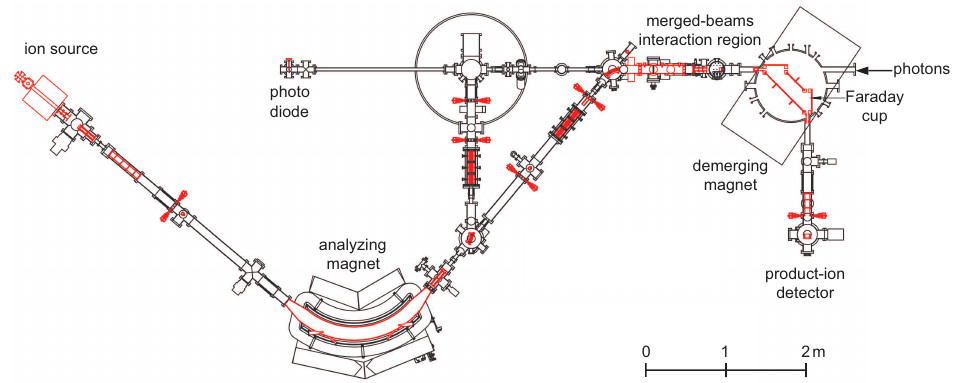
Figure 1. Sketch of the photon-ion merged-beams setup PIPE (Photon-Ion spectrometer at PETRA III). Ion-optical elements, such as focusing lenses, beam deflectors, collimating slits and Faraday cup are drawn in red color. This figure is a differently labeled version of Figure 2 from [33] (reproduced by permission of the